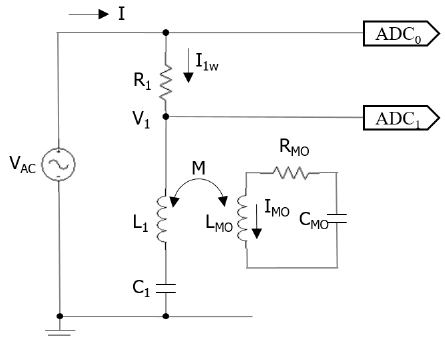
Figure 3. Equivalent metal object detection circuit when a metallic object (MO) is inserted between the transmitting and receiving coils.